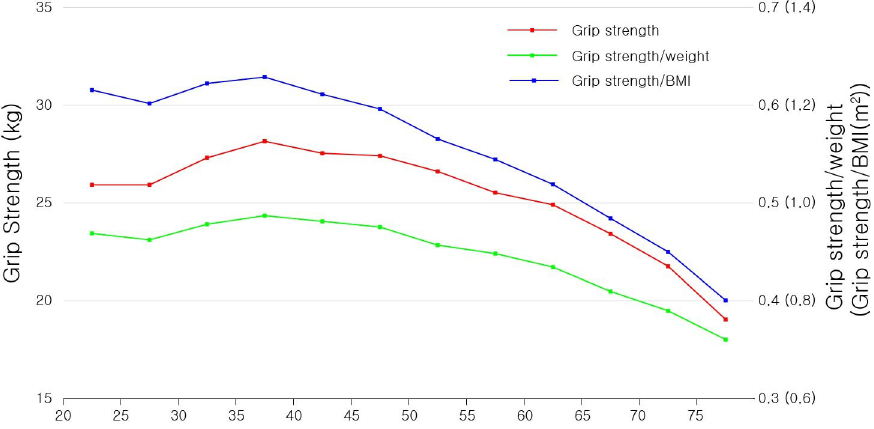
Fig 3. Grip strength, grip strength/body weight, and grip strength/BMI by age in women. BMI, body mass index.